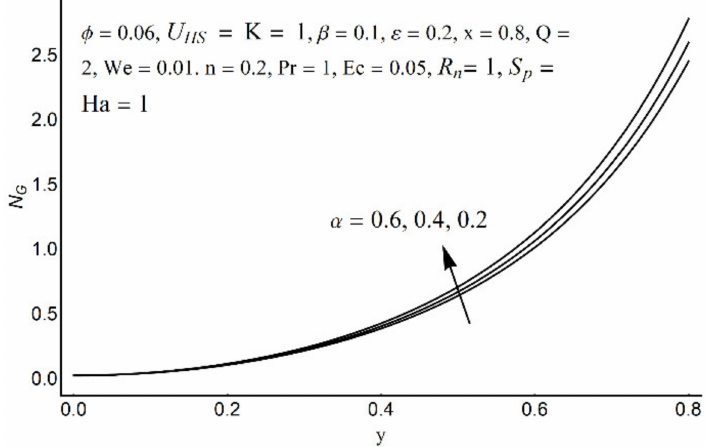
Figure 18. Entropy generation number for different values of α